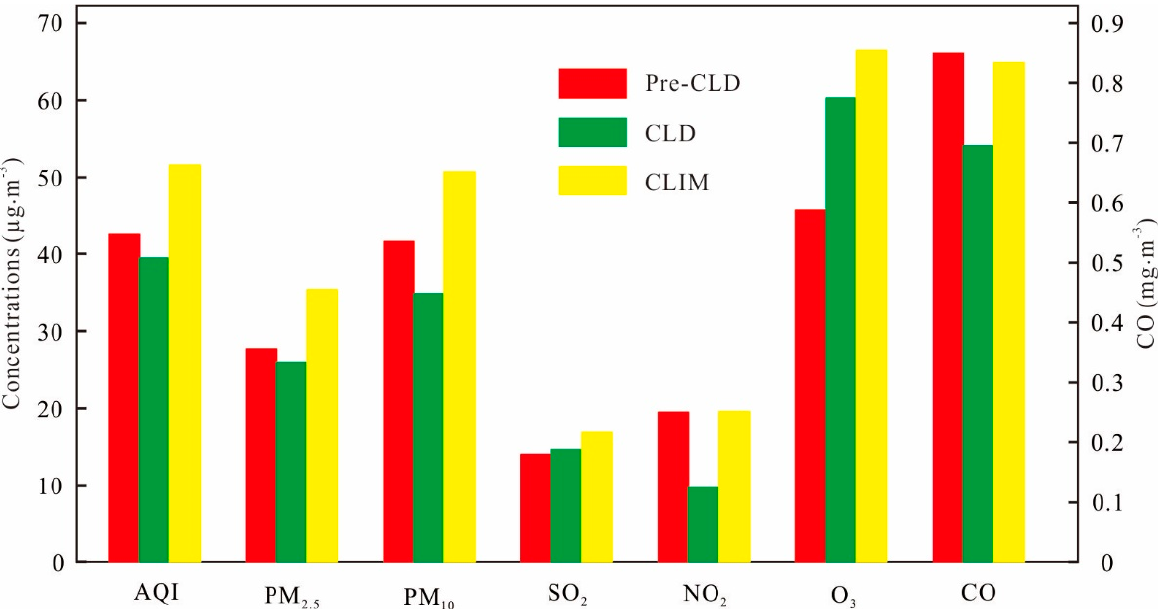
Figure 2. Average air quality during the pre-lockdown, lockdown, and the identical lunar period during the past 3 years (CLD: Three week COVID19 lockdown period from 23 January to 13 February 2020; pre-CLD: Three weeks before CLD for from 1 January to 22 January 2020; CLIM: 2017–2019 year, the same as that in 2020-CLD in the Chinese lunar calendar).